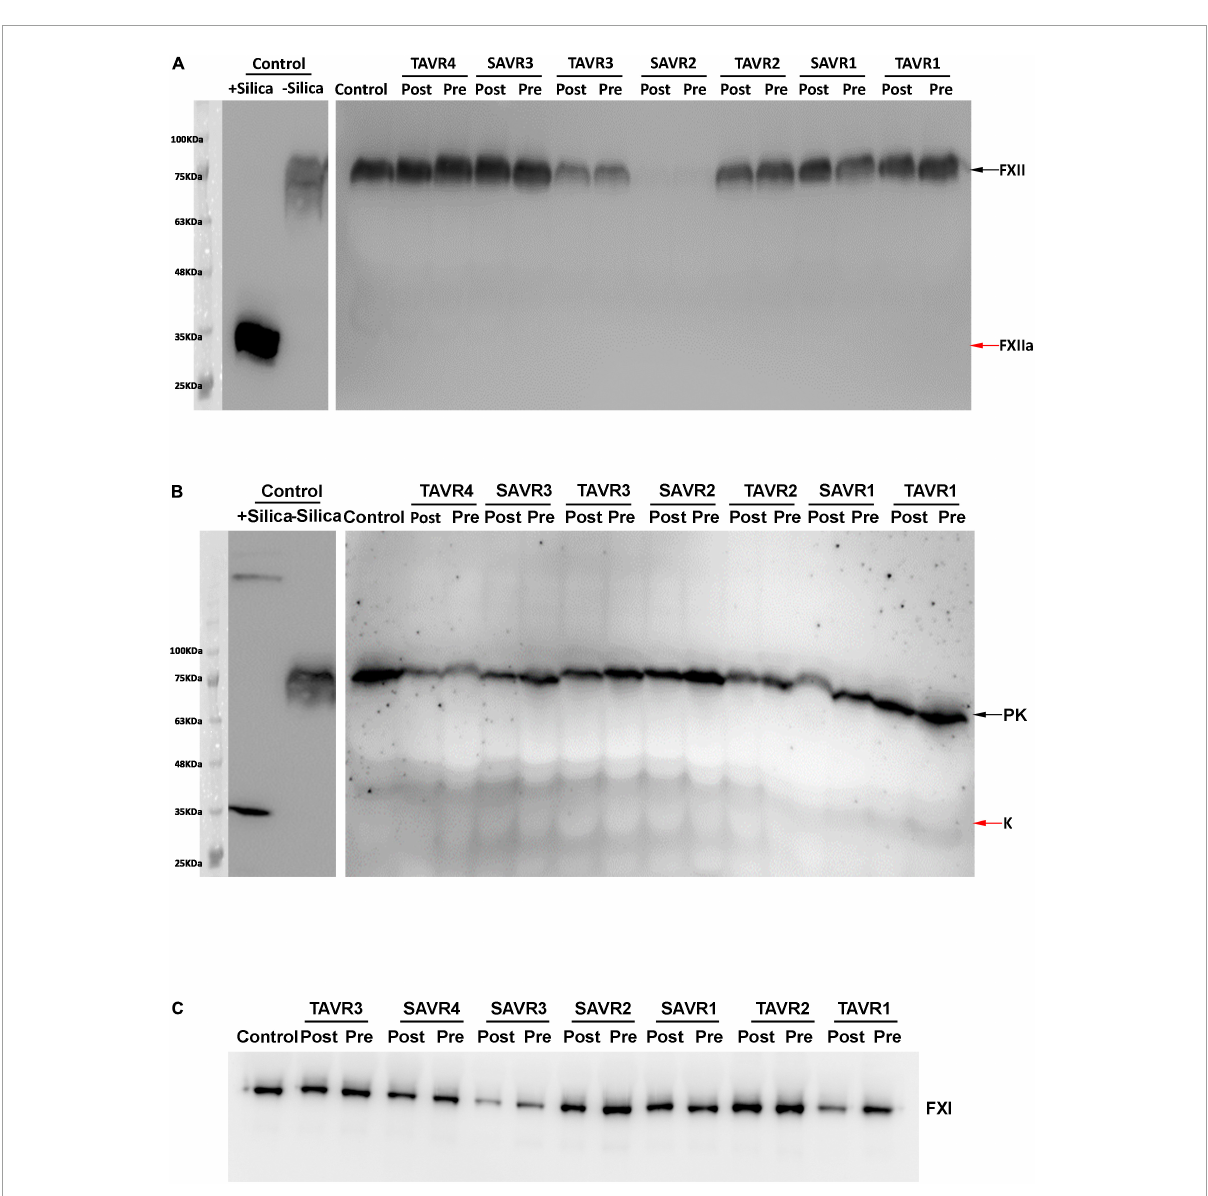
FIGURE2 Plasma FXII (A) , Pre(Kallikrein) (B) , and FXI (C) detected by Western Blot after SDS-PAGE in representative samples of patients underwent TAVR or SAVR. The samples pre and post-procedure are indicated. Zymogens are pointed by black arrows, while activated forms are pointed by red arrows. As control of activation, plasma from a pool of 100 healthy blood donors was treated with